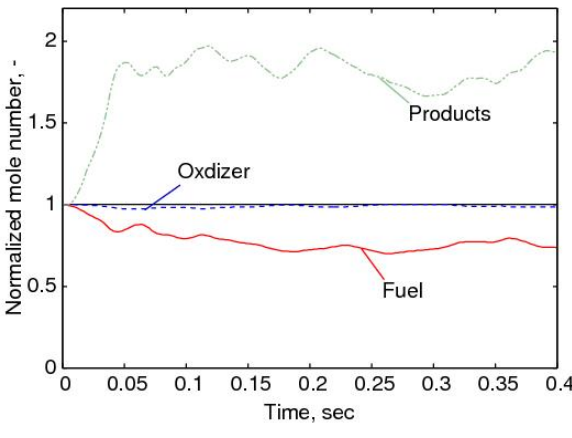
Figure 21. Comparison of mole number normalized by initial values obtained by using coarser